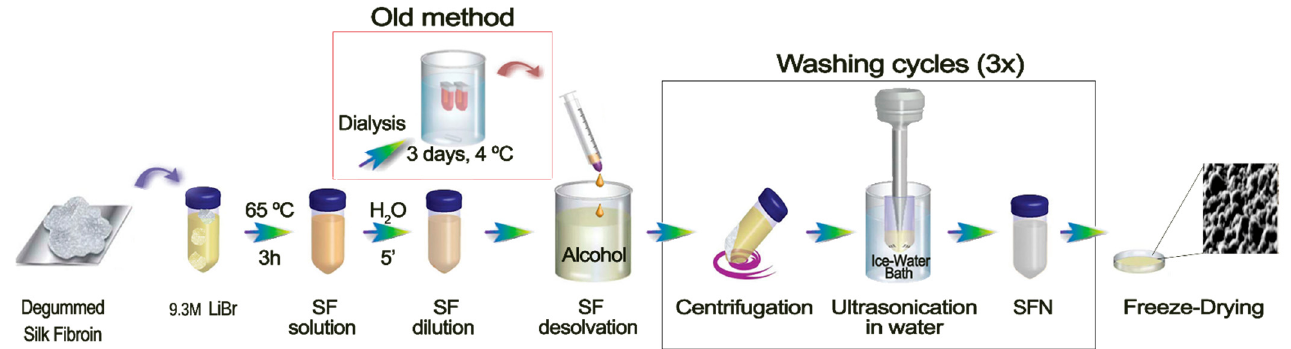
Figure 1. Scheme of the protocol developed for SF dissolution and consequent SFN preparation. Inside the red square is shown the traditional route and in the black square is highlighted the washing cycles necessary for the LiBr cleaning.